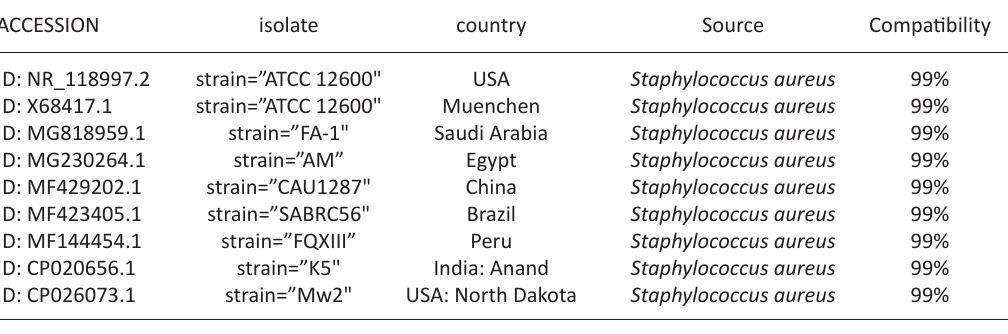
Table 2. Sequencing ID in gene bank, and compatibility of DNA sequences obtained from National Center Biotechnology Information (NCBI).